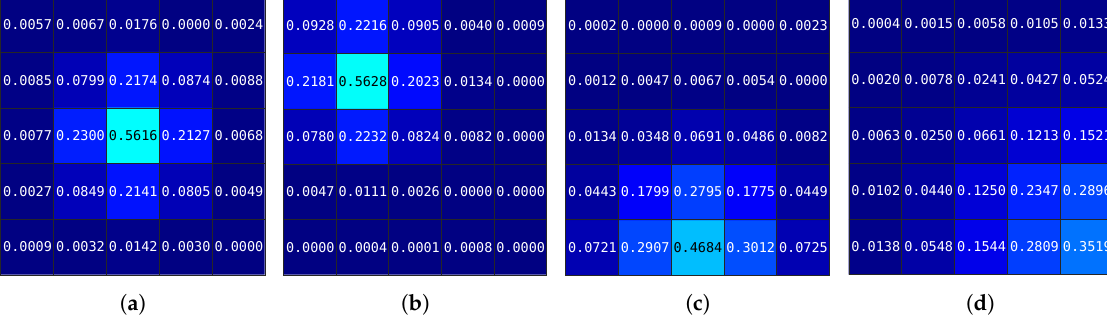
Figure 5. Normalized energy—irradiance—distribution relative to the highest irradiance cell when the laser module was located away from the VMJ PV cell array: suitable experimental setup in Table 1 is ( a ) setup #1, ( b ) setup #2, ( c ) setup #3, and ( d ) setup #4.